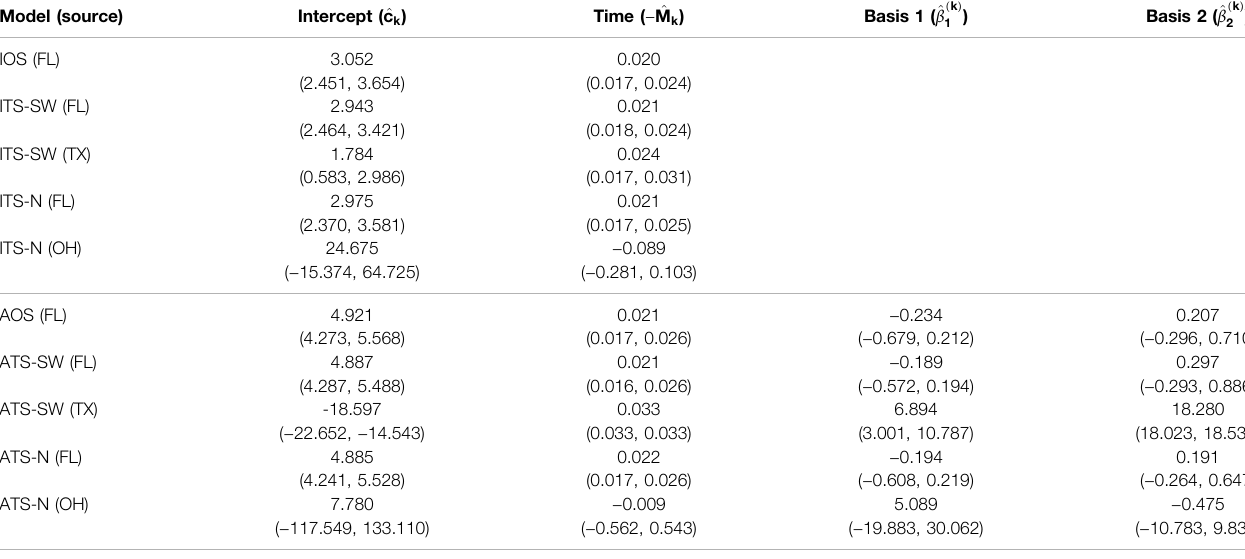
TABLE 3| Parameterestimates and95%con fi dence intervalsforone-and two-sourcemodels fi tto2008data( n (cid:1) 25).Inthetwo-sourcemodels, twosetsofestimatesare reported corresponding to a northern placement and a southwestern placement for the alternate (non-FL) source. No basis parameters are reported for the isotropic models, since these terms are only included in the anisotropic models (FL - Florida, TX - Texas, OH - Ohio).